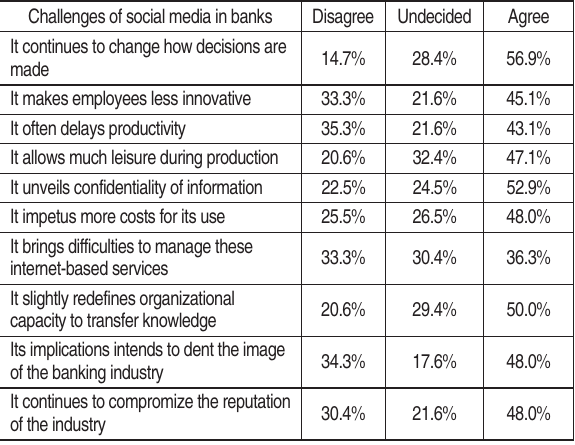
Table 6. Perceptions in business etiquette Challenges of social media in